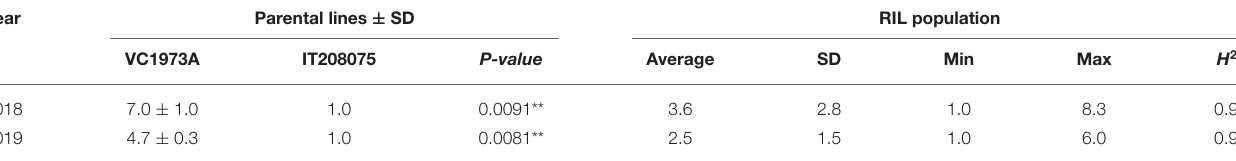
TABLE 1 | Phenotypic variation and heritability ( H 2 ) of the number of upper inflorescences in VC1973A and IT208075 and their derived RIL population. Year Parental lines ± SD RIL population VC1973A IT208075 P-value Average SD Min Max H